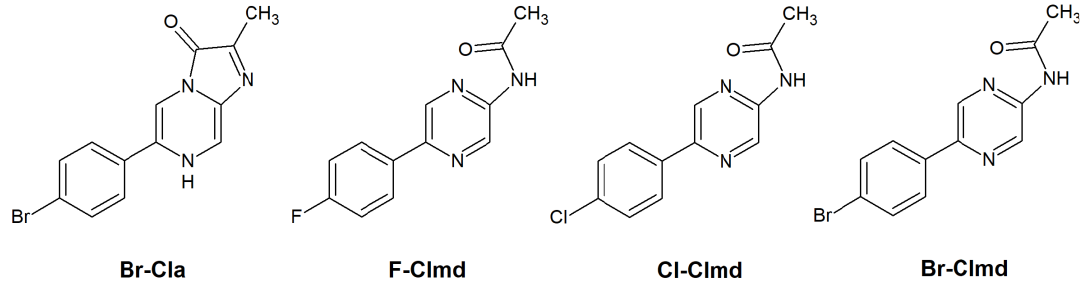
Figure 2. Chemical structures of the halogenated Br-Cla and Clmds (F-, Cl-, and Br-Clmd).